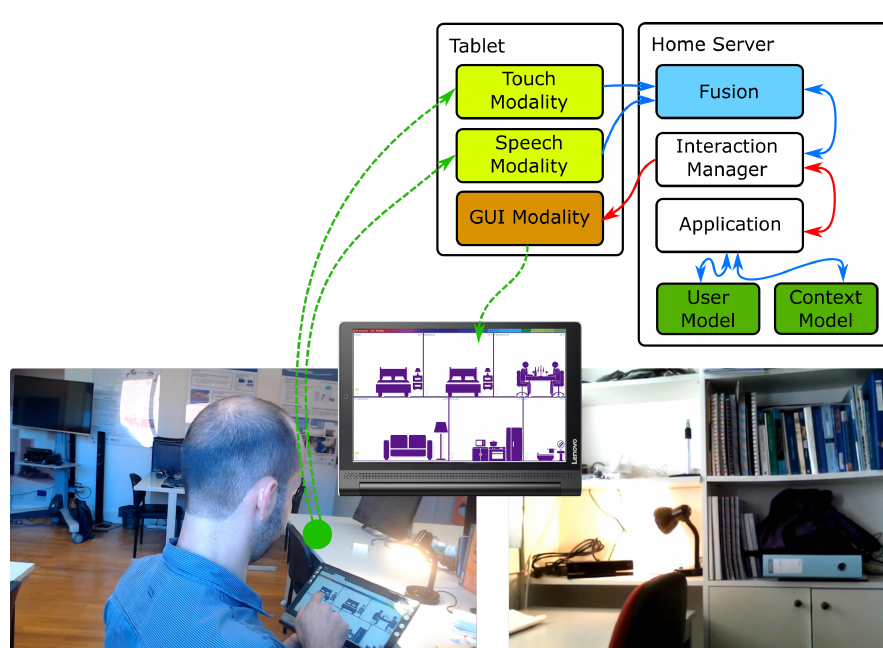
Figure 13. Images illustrating the use of the framework and assistant in the smart home context, while using fusion of speech and touch to turn the light on a different house division.